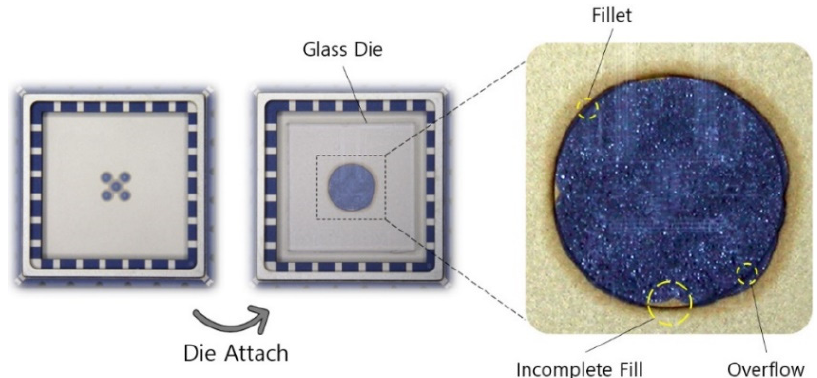
Figure 10. Die ‐ attach pattern and spreading shape of the die adhesive in the pillar die attach.